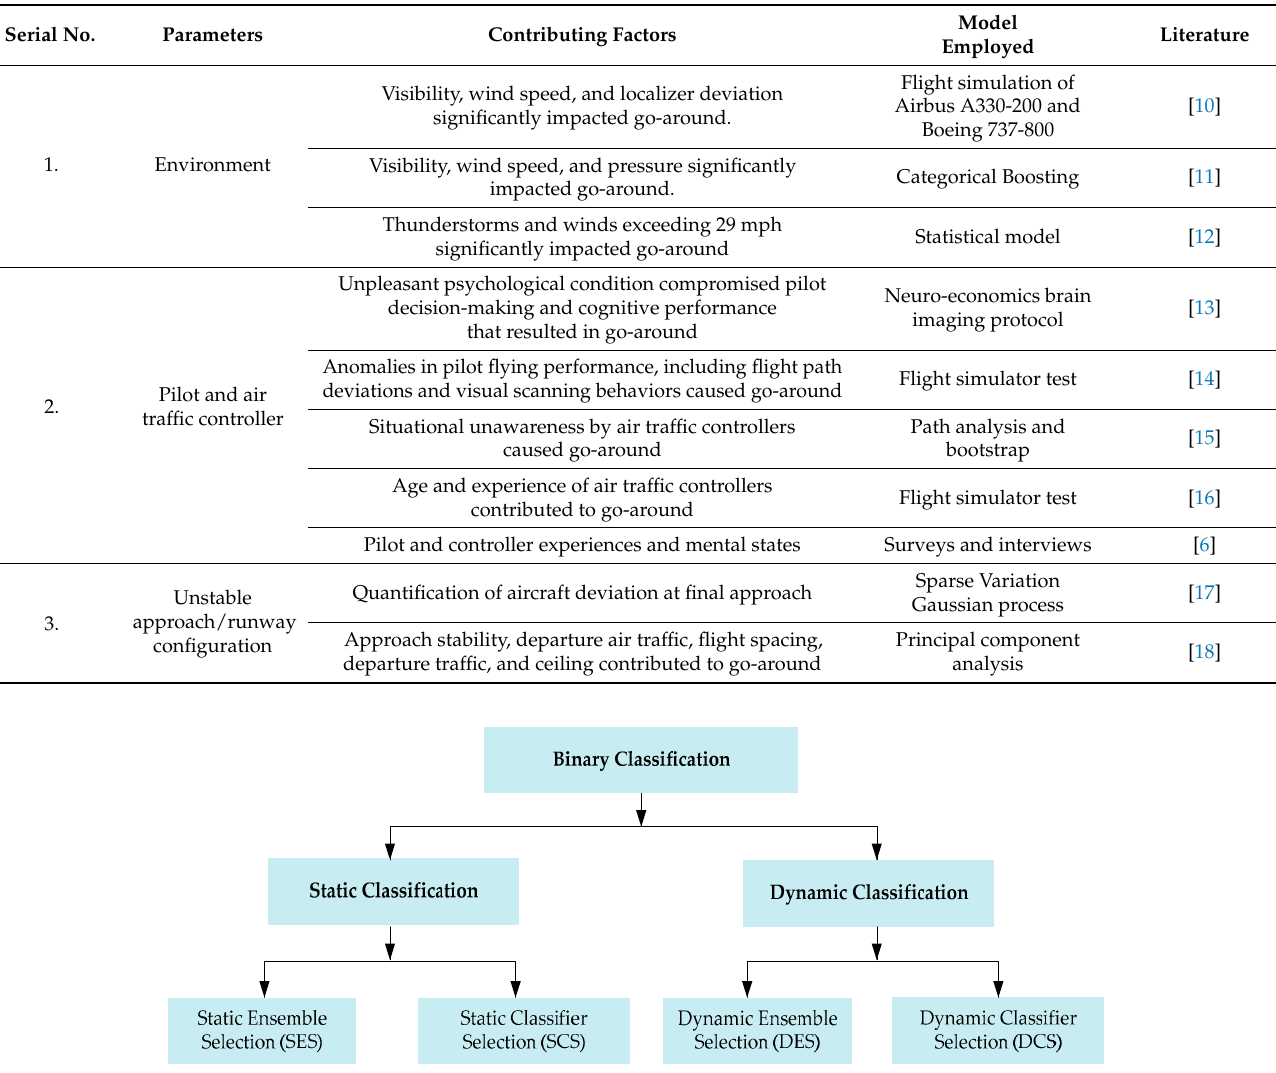
Table 1. Literature on various factors contributing to the occurrence of aircraft go-around.